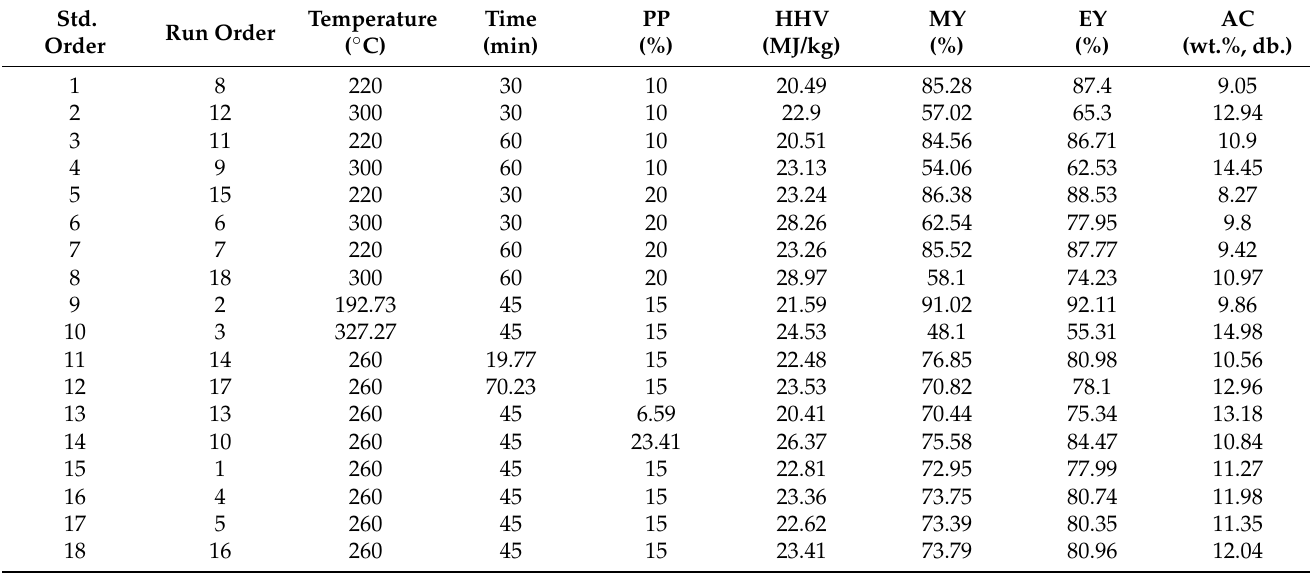
Table 2. Design matrix and responses for biochar